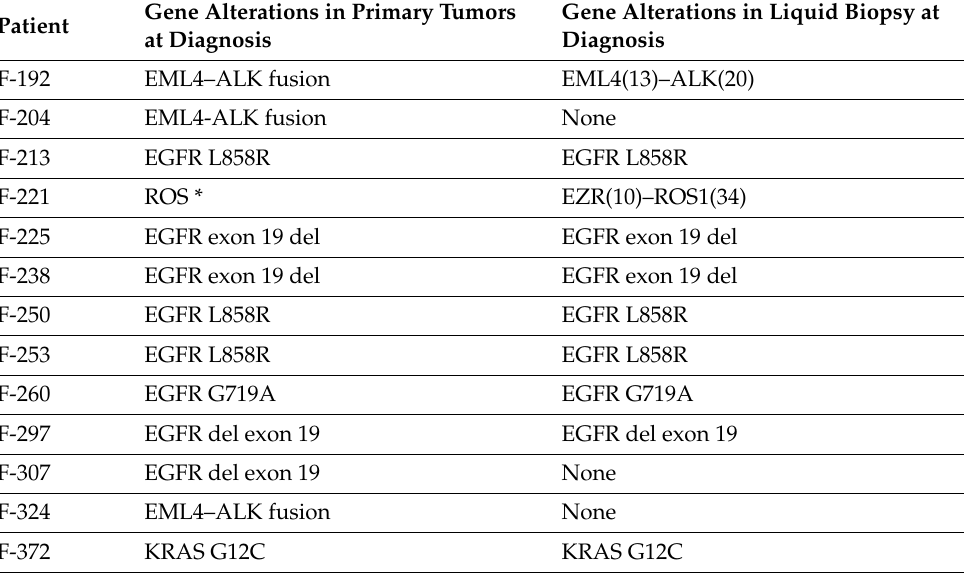
Table 2. Liquid biopsy at